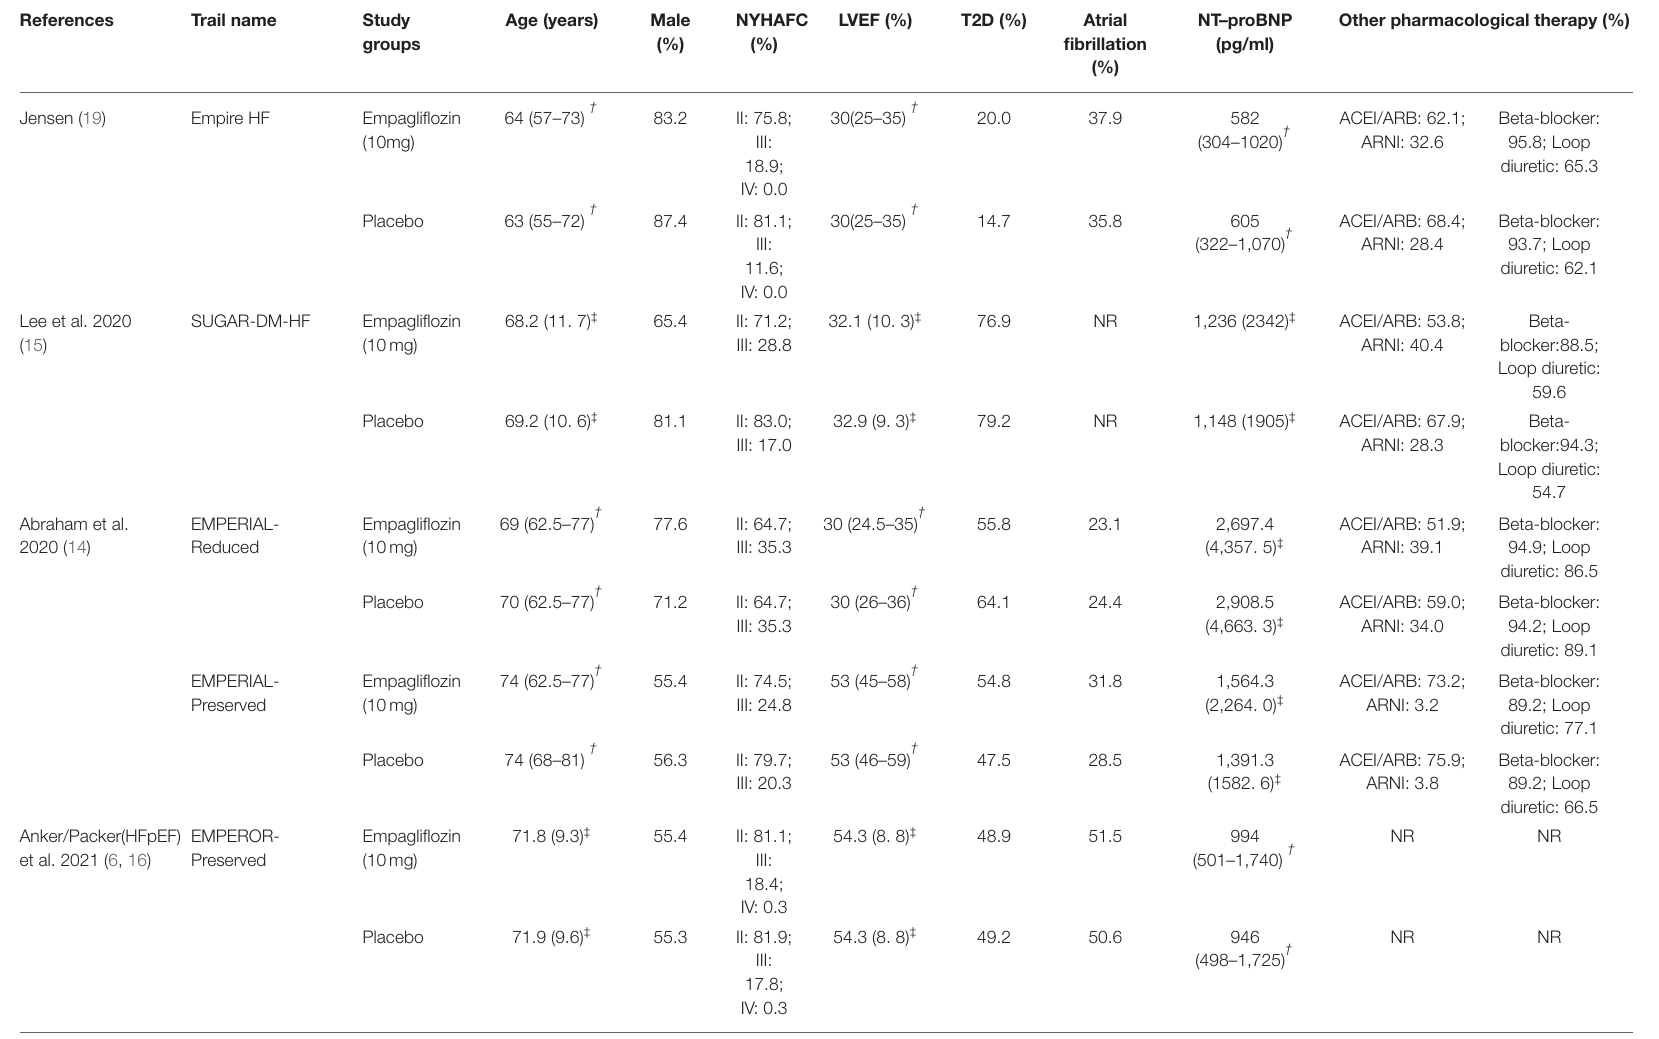
TABLE 1 | Characteristics of population of included